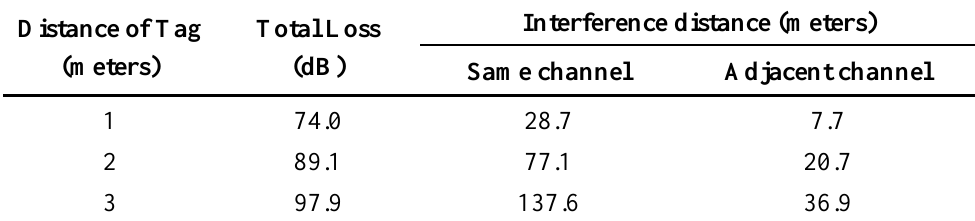
Table 2. Interference distances according to channel differences.